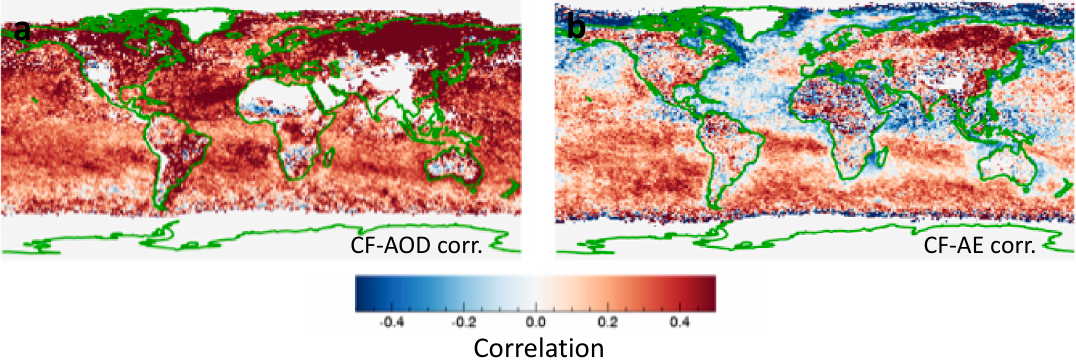
Figure 9. Geographical distribution of the relationship between MODIS cloud fraction and aerosol parameters: ( a ) Aerosol optical depth, and ( b ) Angstrom exponent. The correlations are calculated separately for each 1° by 1° latitude-longitude region, for June–July–August in 2012–2014. The figure is based on Figures 2a and 4a of [42].